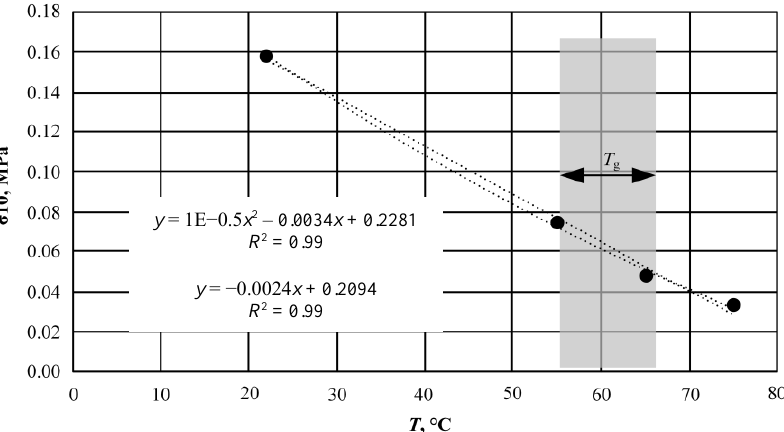
Fig. 4. Relationship of compressive strength with test T°.